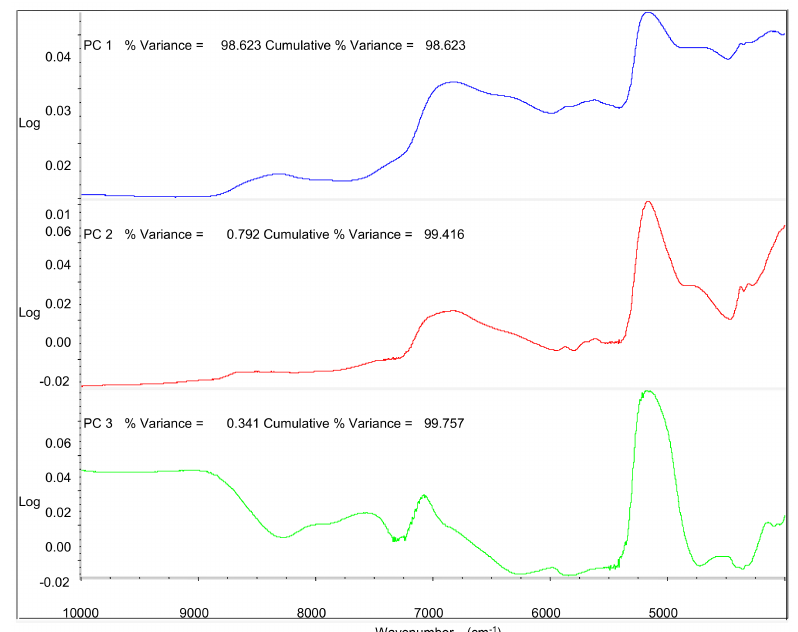
Figure 5. The correlative near infrared spectrum (NIRS) regions used for the classification of four different main-cultivated areas of PC1, PC2 and